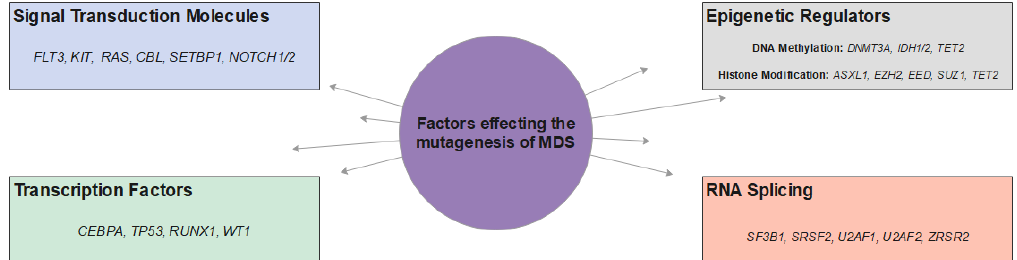
Figure 1. Molecular pathogenesis of MDS. Signal transduction molecules refer to gene mutations resulting in alteration to proliferative or apoptotic effects. Transcription factors and epigenetic regulators exert effects at both transcriptional and translational levels due to aberrations in RNA splicing, DNA methylation, and histone modification.